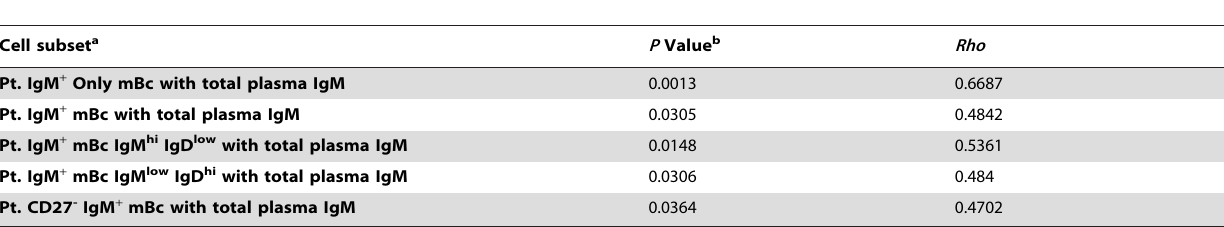
Table 1. Memory B cell subsets that correlate with total immunoglobulins.